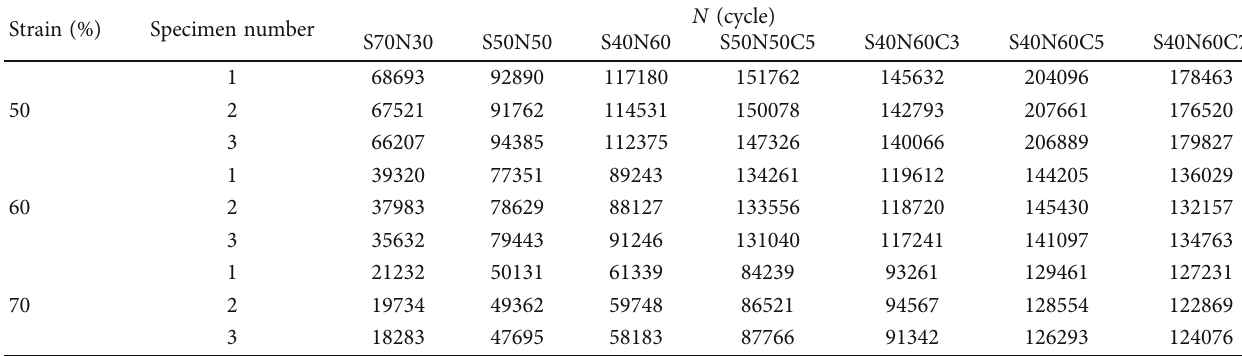
Table 4: Rubber fatigue life with di ff erent properties at 50%, 60%, and 70% strain values.